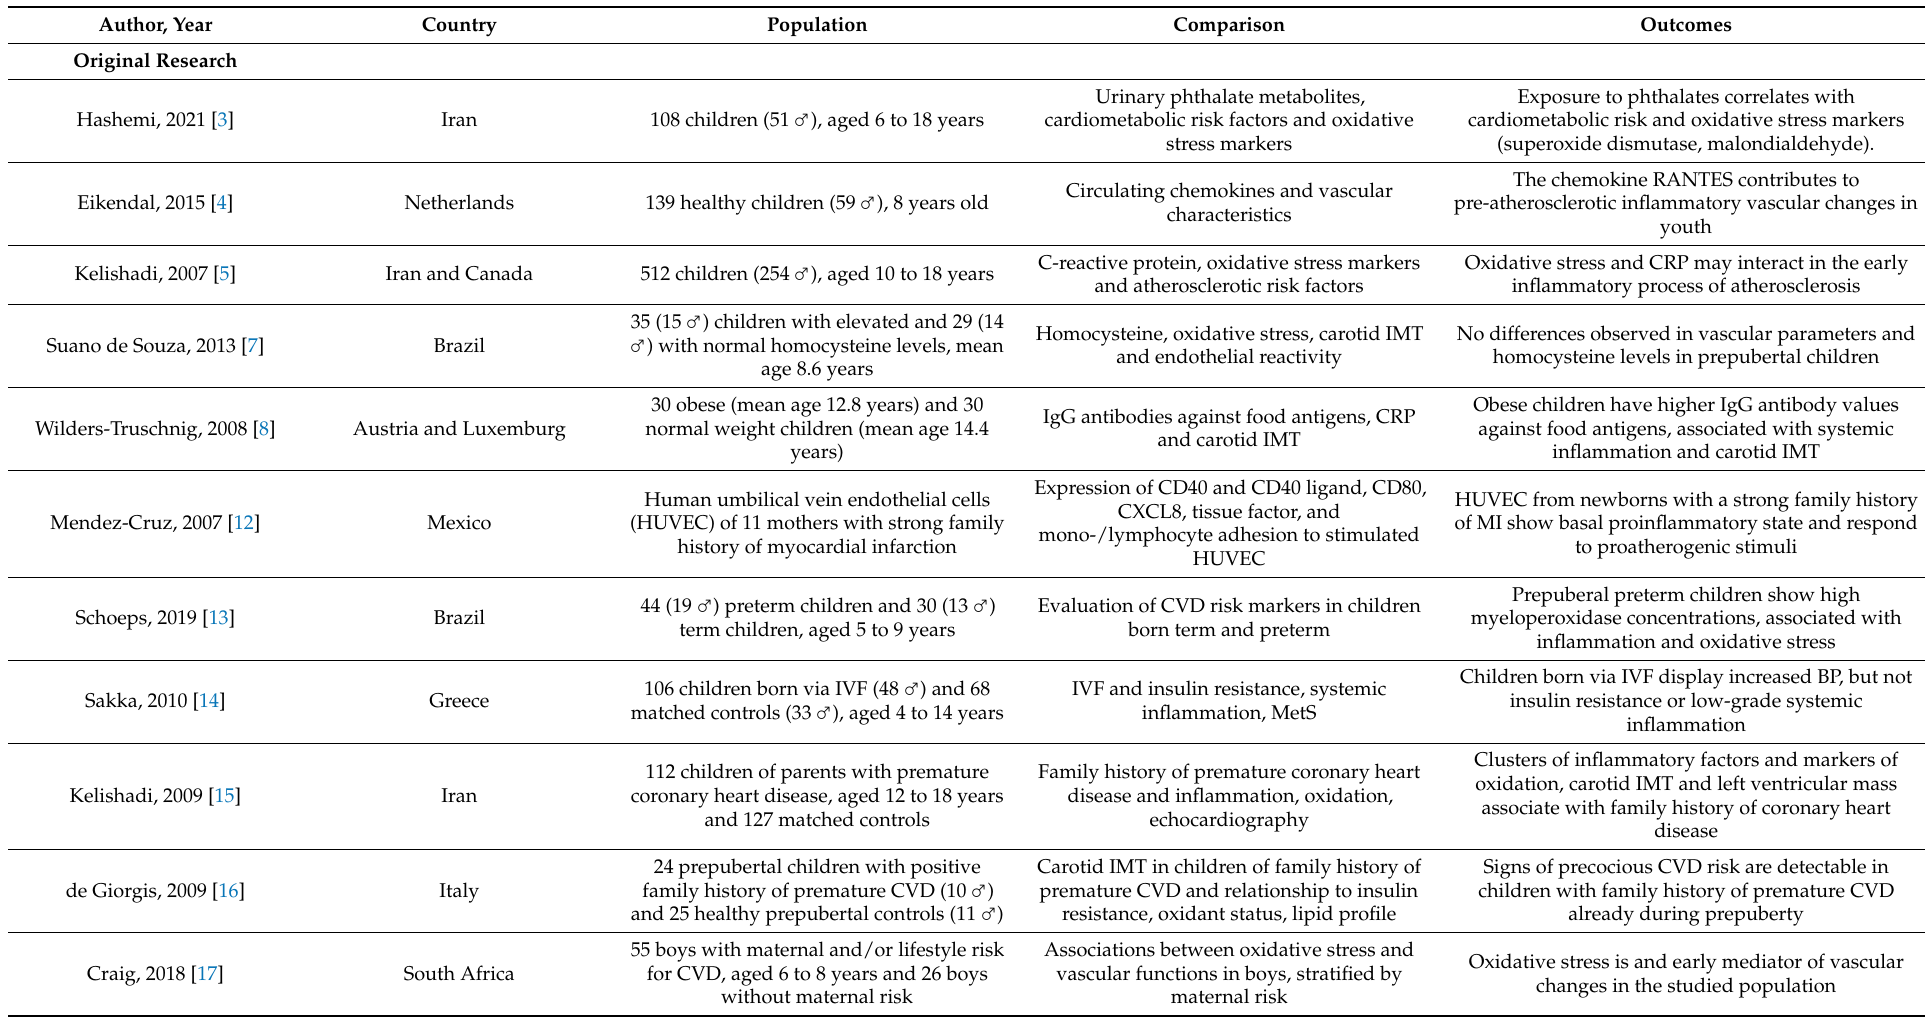
Table 1. Table of reported studies, reported by population, comparisons and study outcomes. Numbers as reported in the